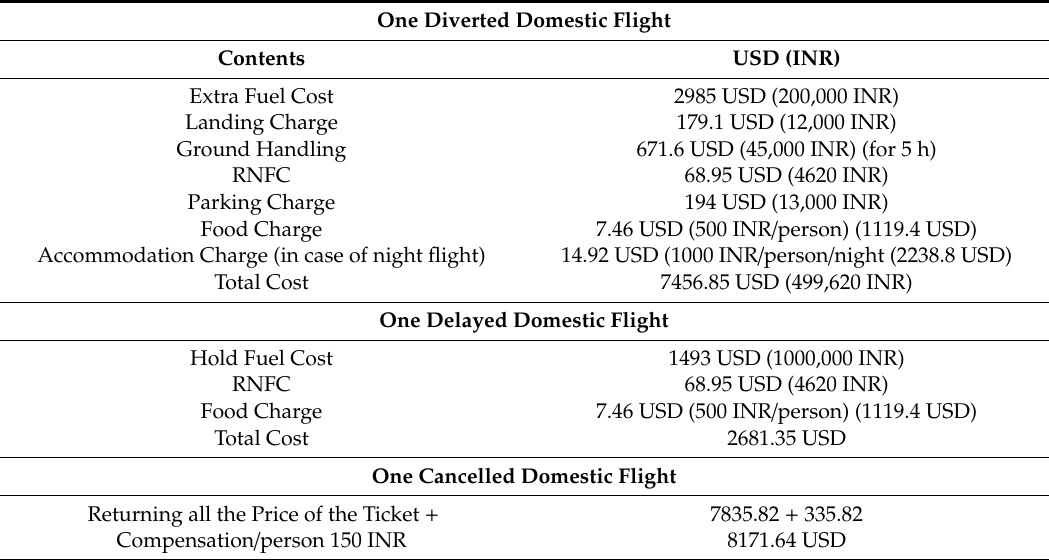
Table 2. Breakdown of charges for domestic flight operations as per the Center for Asia Pacific Aviation (CAPA)